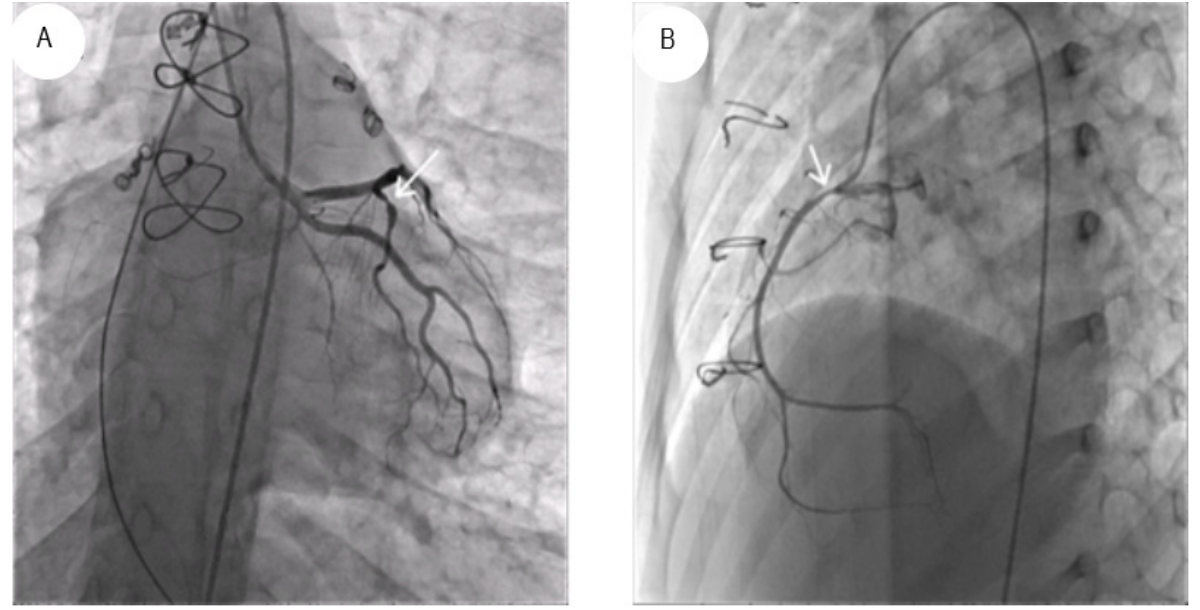
Figure 6. Show severe epicardial CAV in the left ( A ) and right coronary artery ( B ).